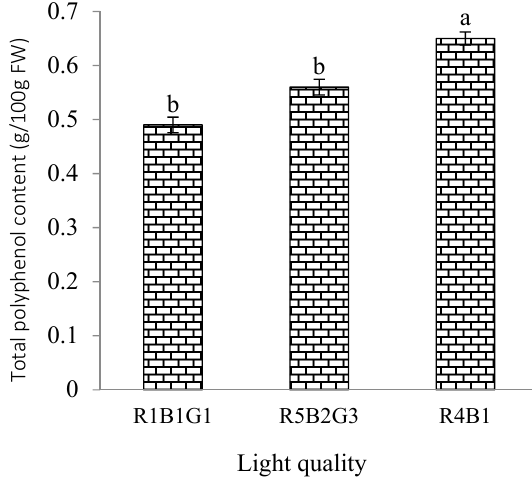
Figure 7. Effects of LEDs with a different light quality at the same intensity on some nutritional parameters of hydroponically cultivated spinach (30 DAT). The error bars show the standard errors. Data were analyzed by R software. Different letters indicate a significant difference among treatments ( p ≤ 0.05).